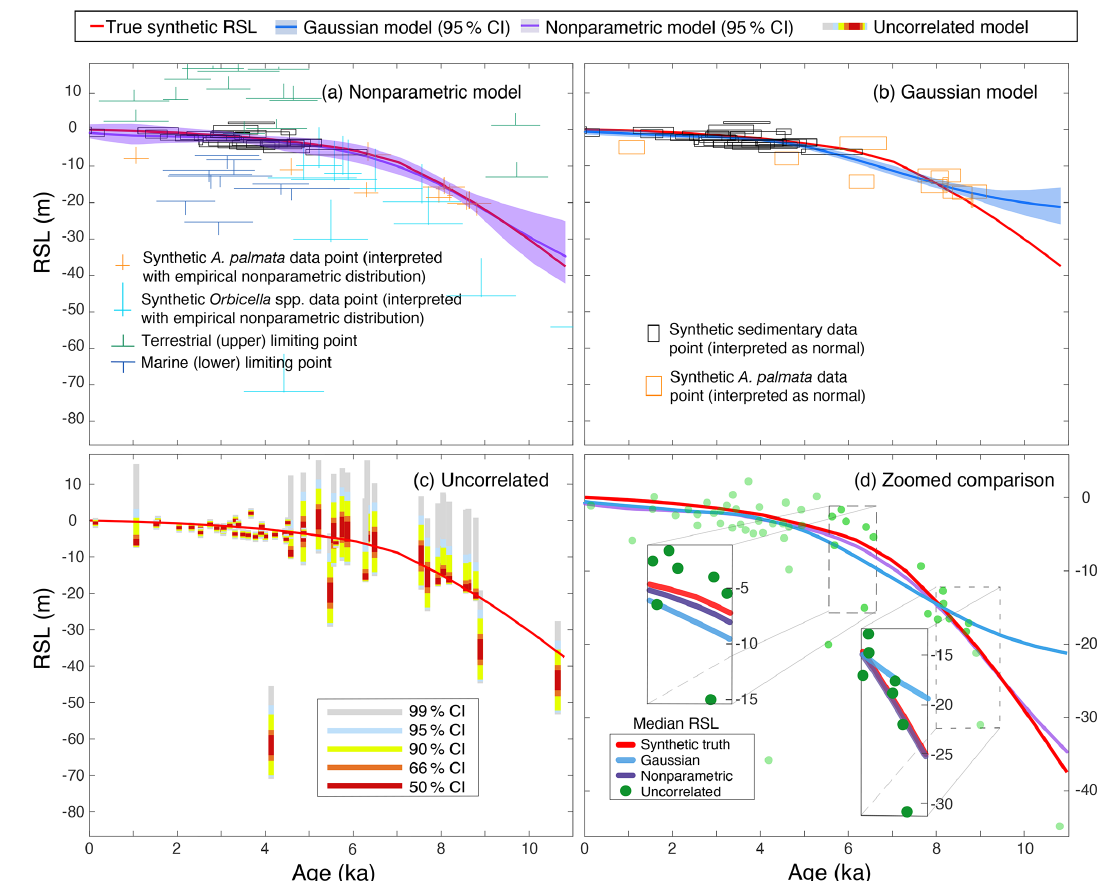
Figure 5. Results of validation tests. Comparison of three models using a synthetic dataset based on the modern distributions of Acropora palmata ( A. palmata ) and Orbicella spp., with median relative sea-level (RSL) estimate and 95% credible intervals: (a) the current nonpara- metric model incorporates all available data; (b) the Gaussian model uses the same interpretations of data as in Khan et al. (2017) but samples to incorporate distributions on parameters; (c) the uncorrelated model, similar to Hibbert et al. (2016), uses sampling to infer the probability of RSL at specific times based on modern empirical distributions but without consideration of correlations in time; and (d) predictions from all three models in a single overlapping plot with insets showing model